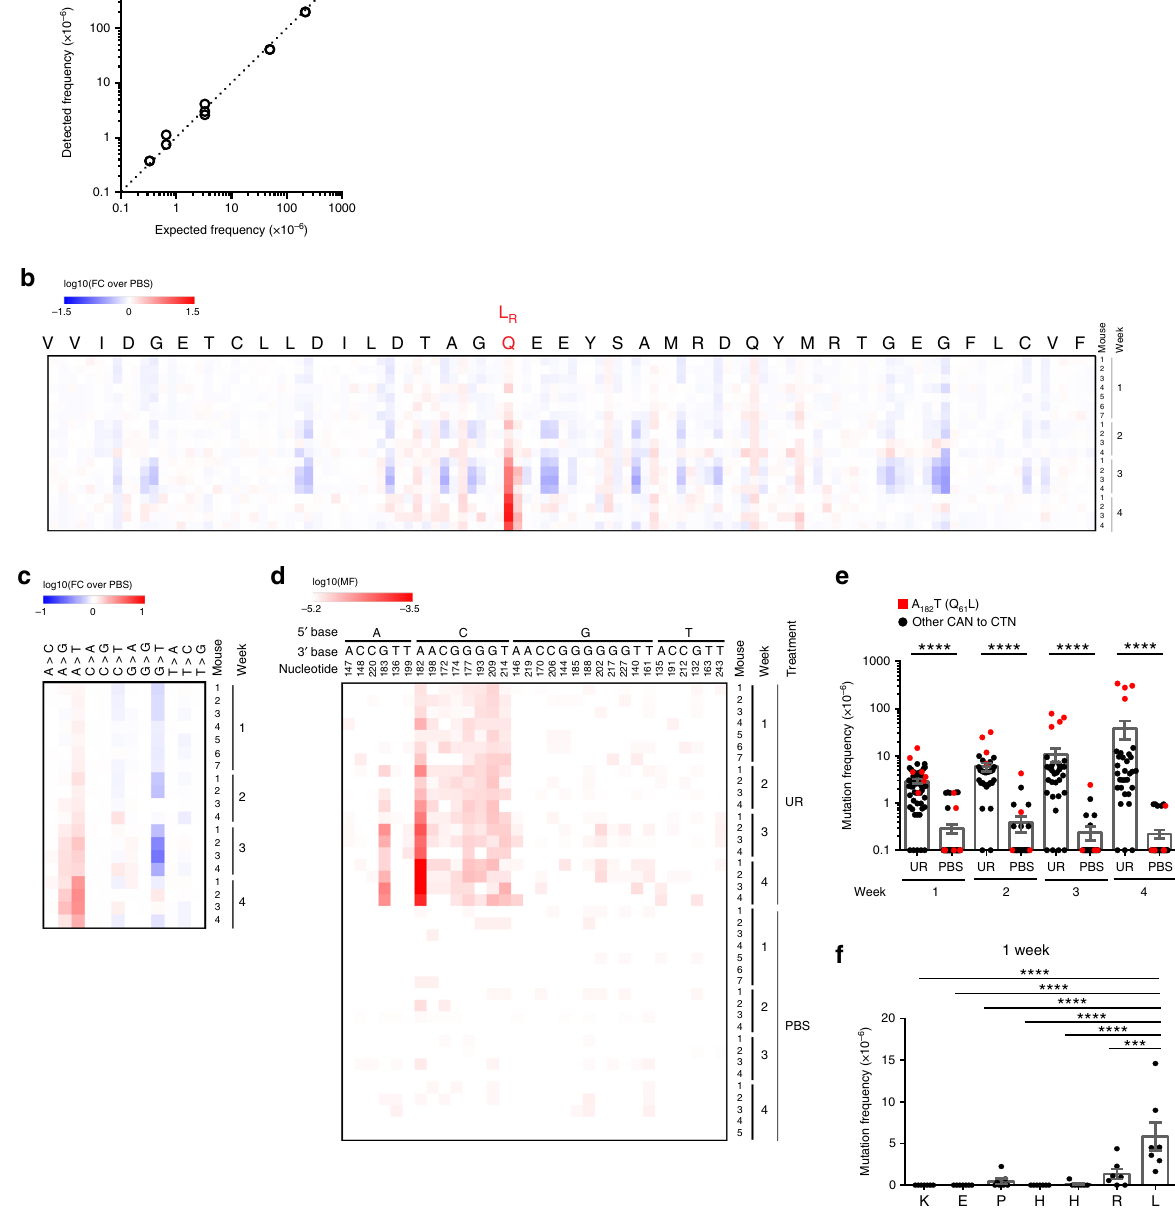
Fig. 1 MDS detects ultra-rare mutations induced by the carcinogen urethane. a Frequency of single (detected) versus co-occurring (present) mutations identi fi ed by MDS using a dilution series of Kras cDNAs with 2 – 3 different mutations engineered in exon 1 mixed with genomic DNA from mouse lung tissue. b – d Heatmap of the mutation frequency (MF) determined by MDS for the non-transcribed strand of exon 2 of Kras from the lungs of mice at the indicated time points after exposure to urethane (UR) or PBS ( n = 7 mice for the UR and PBS cohorts at week 1, 5 mice for the PBS cohort at week 4, and 4 mice for all other cohorts from one experiment), plotted as ( b , c ) the log-transformed fold-change normalized to PBS-treated mice (FC over PBS) or ( d ) log-transformed versus each ( b ) nucleotide (annotated by amino acid at the top, Q 61 L and R mutations are highlighted in red, scaled by detected frequency), ( c ) type of substitution or ( d ) A>T transversions (nucleotide number as well as the 5 ʹ and 3 ʹ base of the substituted A are shown at the top). e , f Mean ± SEM mutation frequency of ( e ) each possible CAN to CTN transversion at the indicated time points after mice were exposed to urethane (UR) or PBS ( n = 7 mice for the UR and PBS cohorts at week 1, 5 mice for the PBS cohort at week 4, and 4 mice for all other cohorts from one experiment) or ( f ) all possible missense mutations for Q 61 codon in mice 1 week after urethane exposure ( n = 7 mice from one experiment). p values calculated by e Dunn ’ s multiple comparison test following Kruskal – Wallis test or f Holm-Sidak multiple comparisons test following one-way ANOVA. **** p < 0.0001 and *** p <